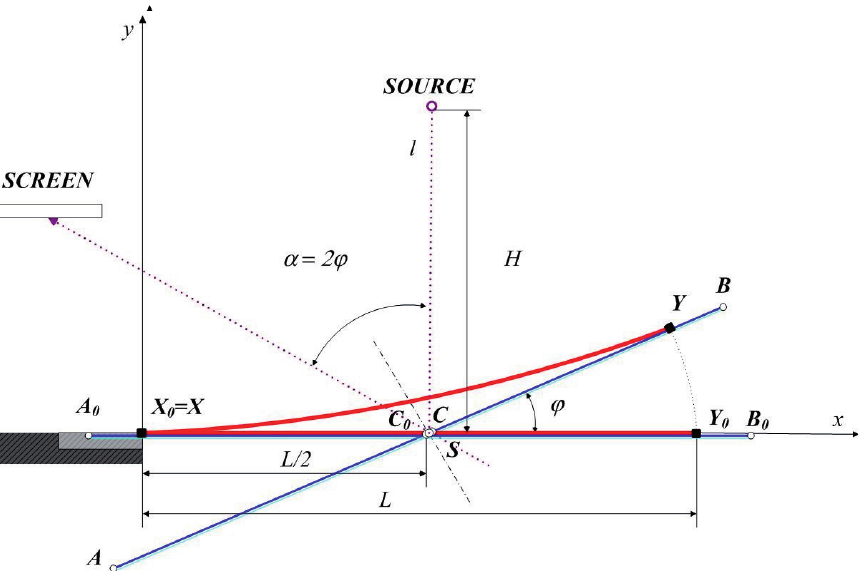
Fig. 6. Geometrical model of the mirror with light